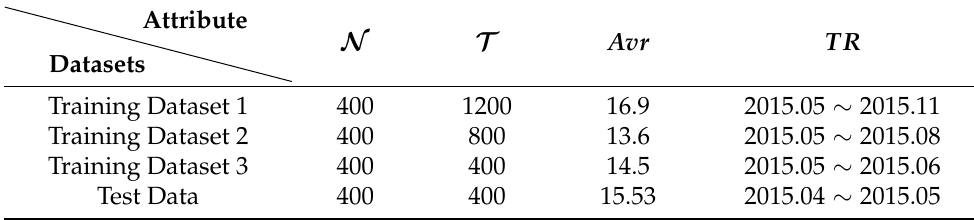
Table 1. Training data description and